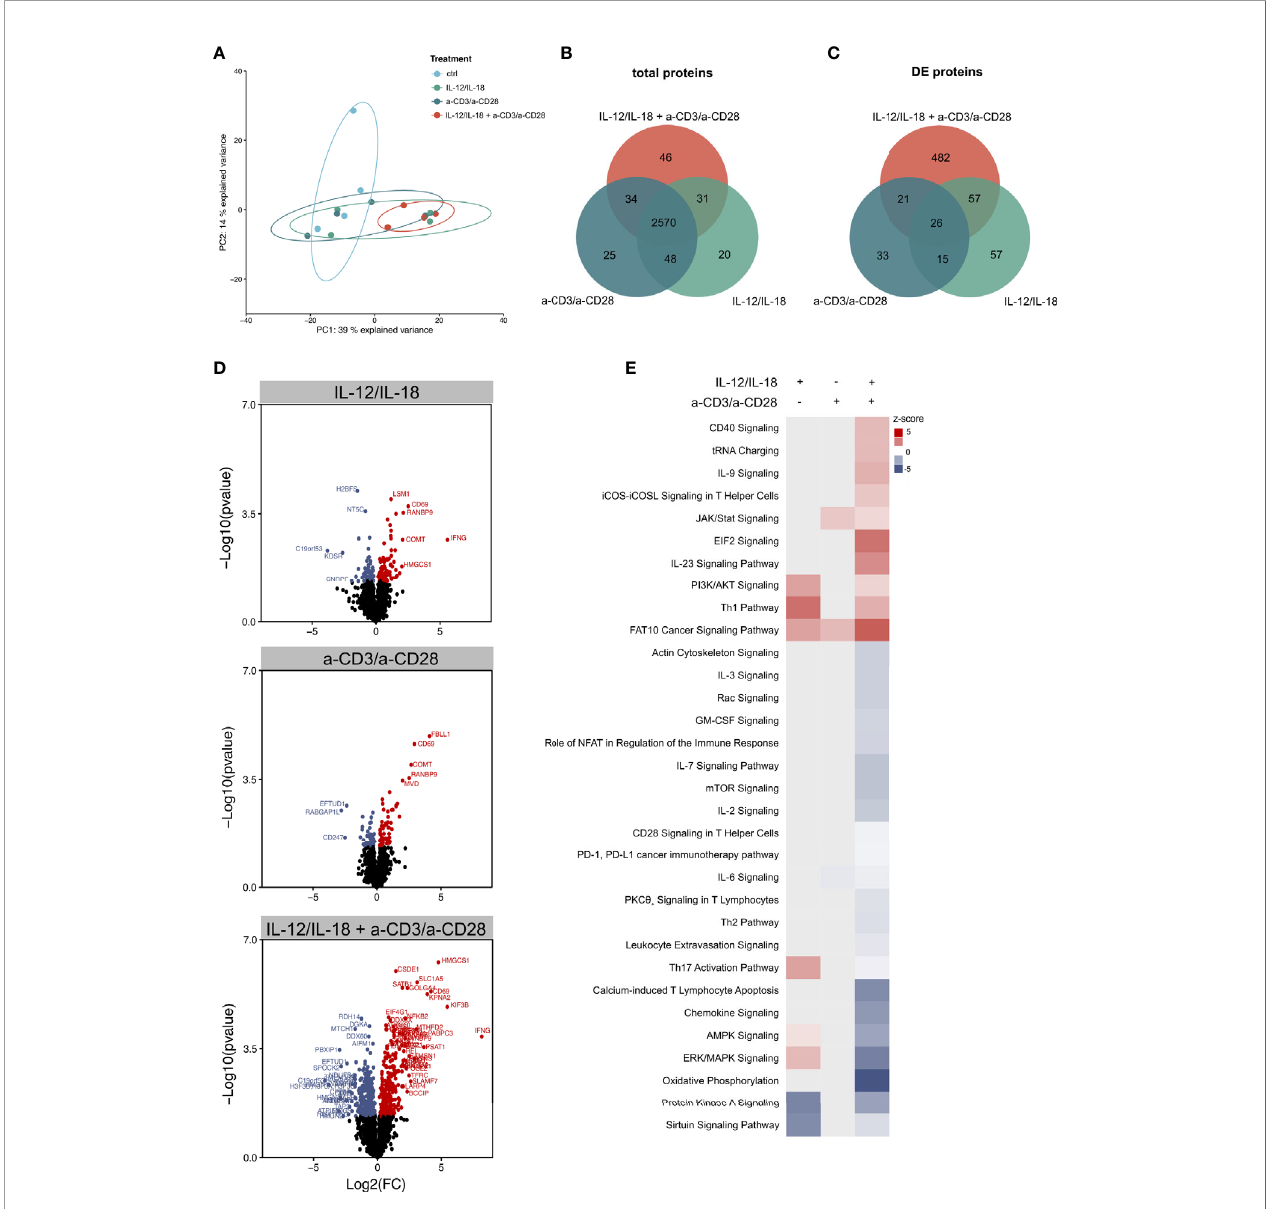
FIGURE 5 | Proteomic pro fi ling of MAIT cell activation. (A) Principle component analysis of the proteome of MAIT cells stimulated with IL-12/IL-18, a-CD3/a-CD28 or a combination of both. Each point represents a single donor (n=4). Overlap of (B) all detected proteins and (C) differentially abundant proteins in stimulated MAIT cells. (D) Volcano plots highlighting differentially abundant proteins in stimulated MAIT cells (p-value ≤ 0.05). (E) Heatmap of selected, signi fi cantly enriched pathways with a z-score re fl ecting up- or downregulation, determined by IPA (padj ≤